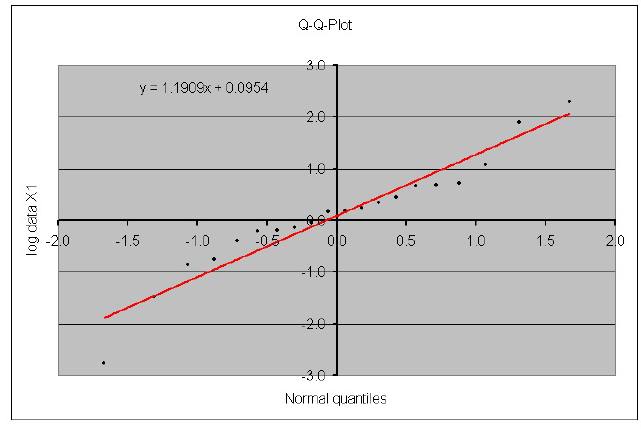
Figure 1. Q-Q-plot for the first risk, log data.